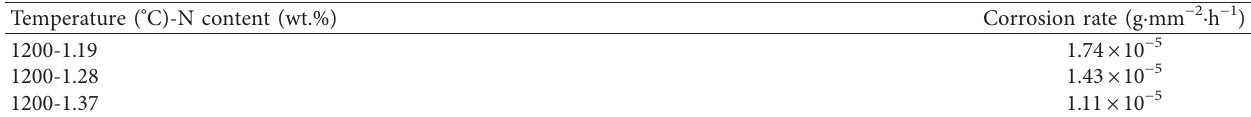
Table 2: Corrosion rates of the HNNS samples with different N contents. Temperature ( ° C)-N content